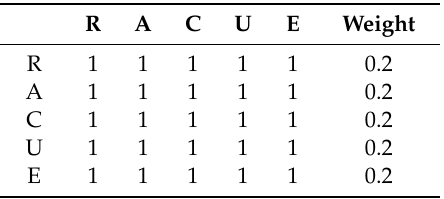
Table A1. Pairwise comparison matrix of urban components.